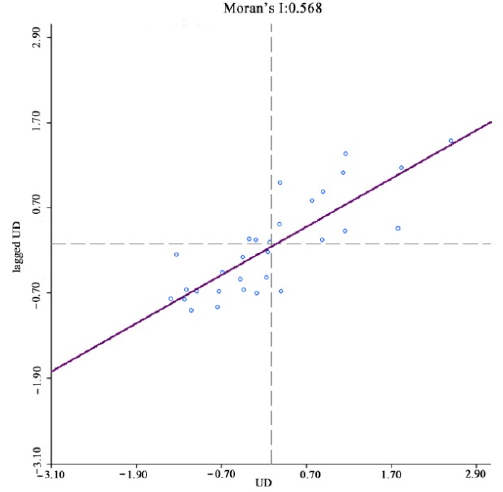
Figure 6. Global Moran’s I of coverage breadth growth.